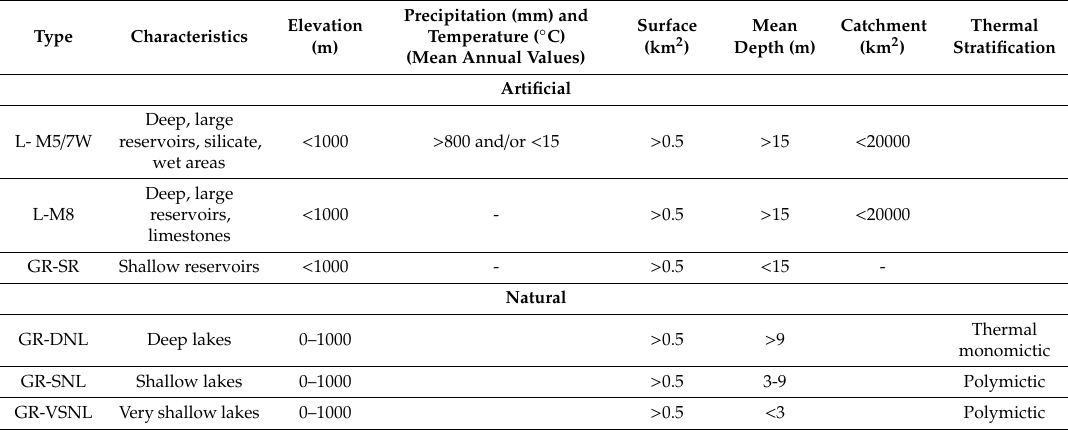
Table 2. WFD national lake types.